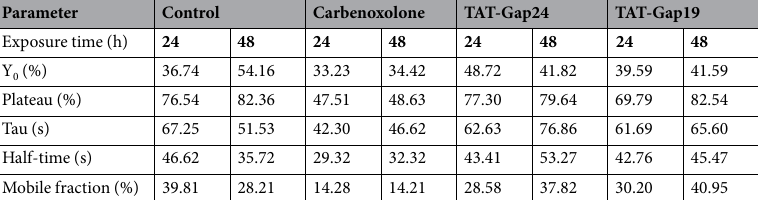
(Fig. 3b). No effects of the peptides were found on ALT and AST levels (Fig. 4a). Effects of TAT-Gap24 and TAT-Gap19 on serum and liver lipids. A principal hallmark of NASH includes the accumulation of lipid droplets in the cytosol of hepatocytes. These droplets consist of triglycerides and are delineated by a phospholipid monolayer. In particular, liver steatosis is triggered by enhanced de novo syn- thesis of fatty acids or increased influx through diet 3 . Moreover, cholesterol induces hepatocellular sensitivity to inflammatory mediators 23 . In fact, cholesterol auto-oxidizes to diverse oxysterols under inflammatory and upreg- ulated oxidative stress conditions. Oxysterols have been suggested to be involved in NASH pathogenesis 24 . In this context, higher amounts of liver triglycerides (p < 0.001) and cholesterol (p < 0.001) were noticed in CHFD-fed mice (n = 14). However, after administration of TAT-Gap24, lower levels of triglycerides (p < 0.05) and choles- terol (p < 0.01) were found in the liver (n = 11) (Fig. 4b). The same holds true for triglycerides (p < 0.05) and